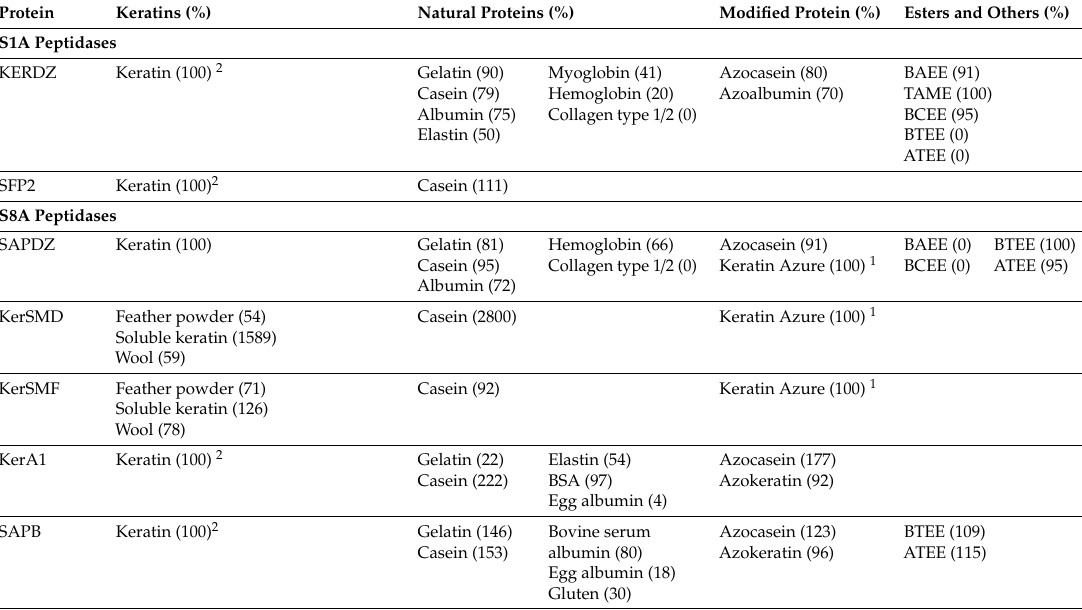
Table 6. Substrate specificity of the selected S1, S8 and M4 keratinases. Numbers in brackets correspond to the % activity relative to other